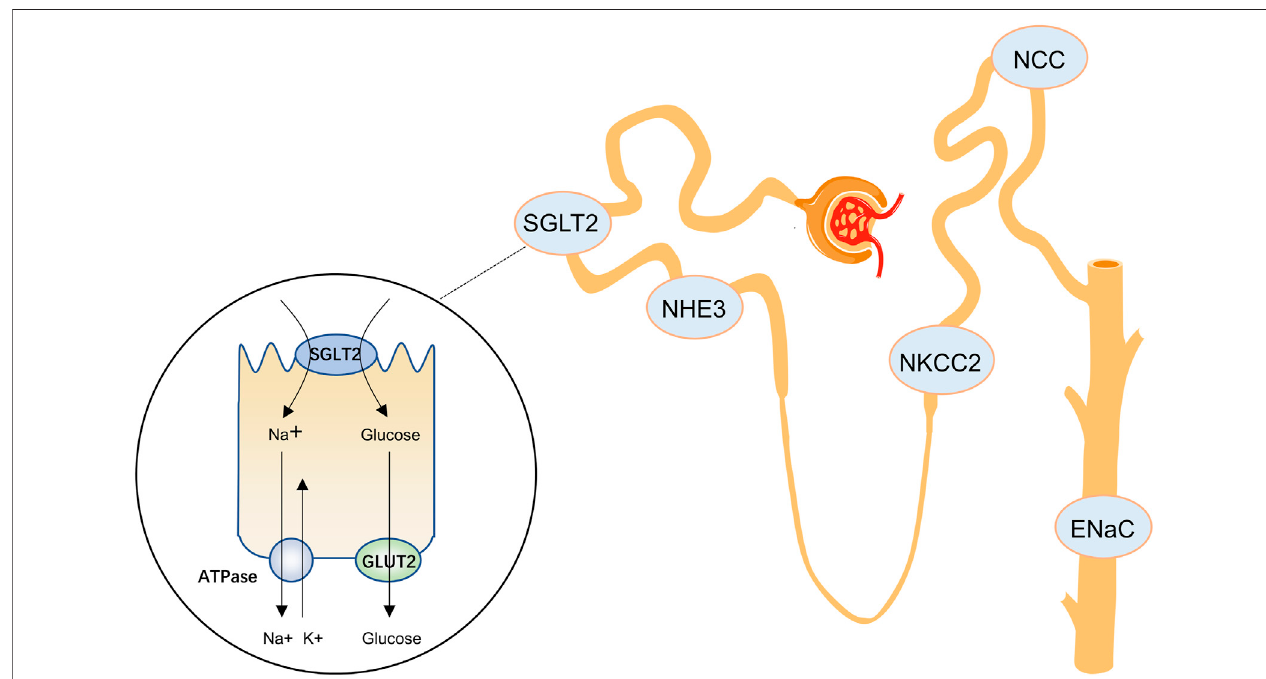
FIGURE 1 | SGLT2 inhibitors and other sodium transporters in the renal tubules. SGLT2, sodium-glucose cotransporter 2; NHE3, Na (+)-H (+) exchanger 3; NKCC2, Na-K-2Cl cotransporter; NCC, Na-Cl cotransporter; ENaC, epithelial sodium channel; GLUT2, glucose transporter 2.